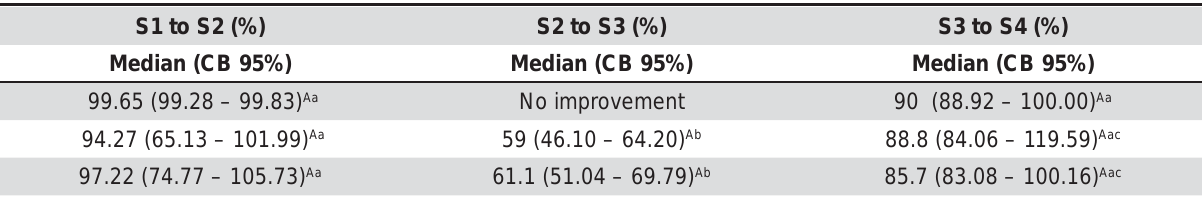
(cid:13)(cid:39)(cid:76)(cid:73)(cid:73)(cid:72)(cid:85)(cid:72)(cid:81)(cid:87)(cid:3)(cid:79)(cid:72)(cid:87)(cid:87)(cid:72)(cid:85)(cid:86)(cid:3)(cid:80)(cid:72)(cid:68)(cid:81)(cid:86)(cid:3)(cid:86)(cid:87)(cid:68)(cid:87)(cid:76)(cid:86)(cid:87)(cid:76)(cid:70)(cid:68)(cid:79)(cid:79)(cid:92)(cid:3)(cid:86)(cid:76)(cid:74)(cid:81)(cid:76)(cid:191)(cid:70)(cid:68)(cid:81)(cid:87)(cid:3)(cid:71)(cid:76)(cid:73)(cid:73)(cid:72)(cid:85)(cid:72)(cid:81)(cid:70)(cid:72)(cid:86)(cid:3)(cid:11)(cid:83)(cid:31)(cid:19)(cid:17)(cid:19)(cid:24)(cid:12) groups (GI, GII and GIII) was performed by using (cid:87)(cid:75)(cid:72)(cid:3)(cid:46)(cid:85)(cid:88)(cid:86)(cid:78)(cid:68)(cid:79)(cid:16)(cid:58)(cid:68)(cid:79)(cid:79)(cid:76)(cid:86)(cid:182)(cid:3)(cid:87)(cid:72)(cid:86)(cid:87)(cid:17)(cid:3)(cid:54)(cid:76)(cid:74)(cid:81)(cid:76)(cid:191)(cid:70)(cid:68)(cid:81)(cid:70)(cid:72)(cid:3)(cid:79)(cid:72)(cid:89)(cid:72)(cid:79)(cid:3)(cid:90)(cid:68)(cid:86)(cid:3)(cid:86)(cid:72)(cid:87)(cid:3) at 5%